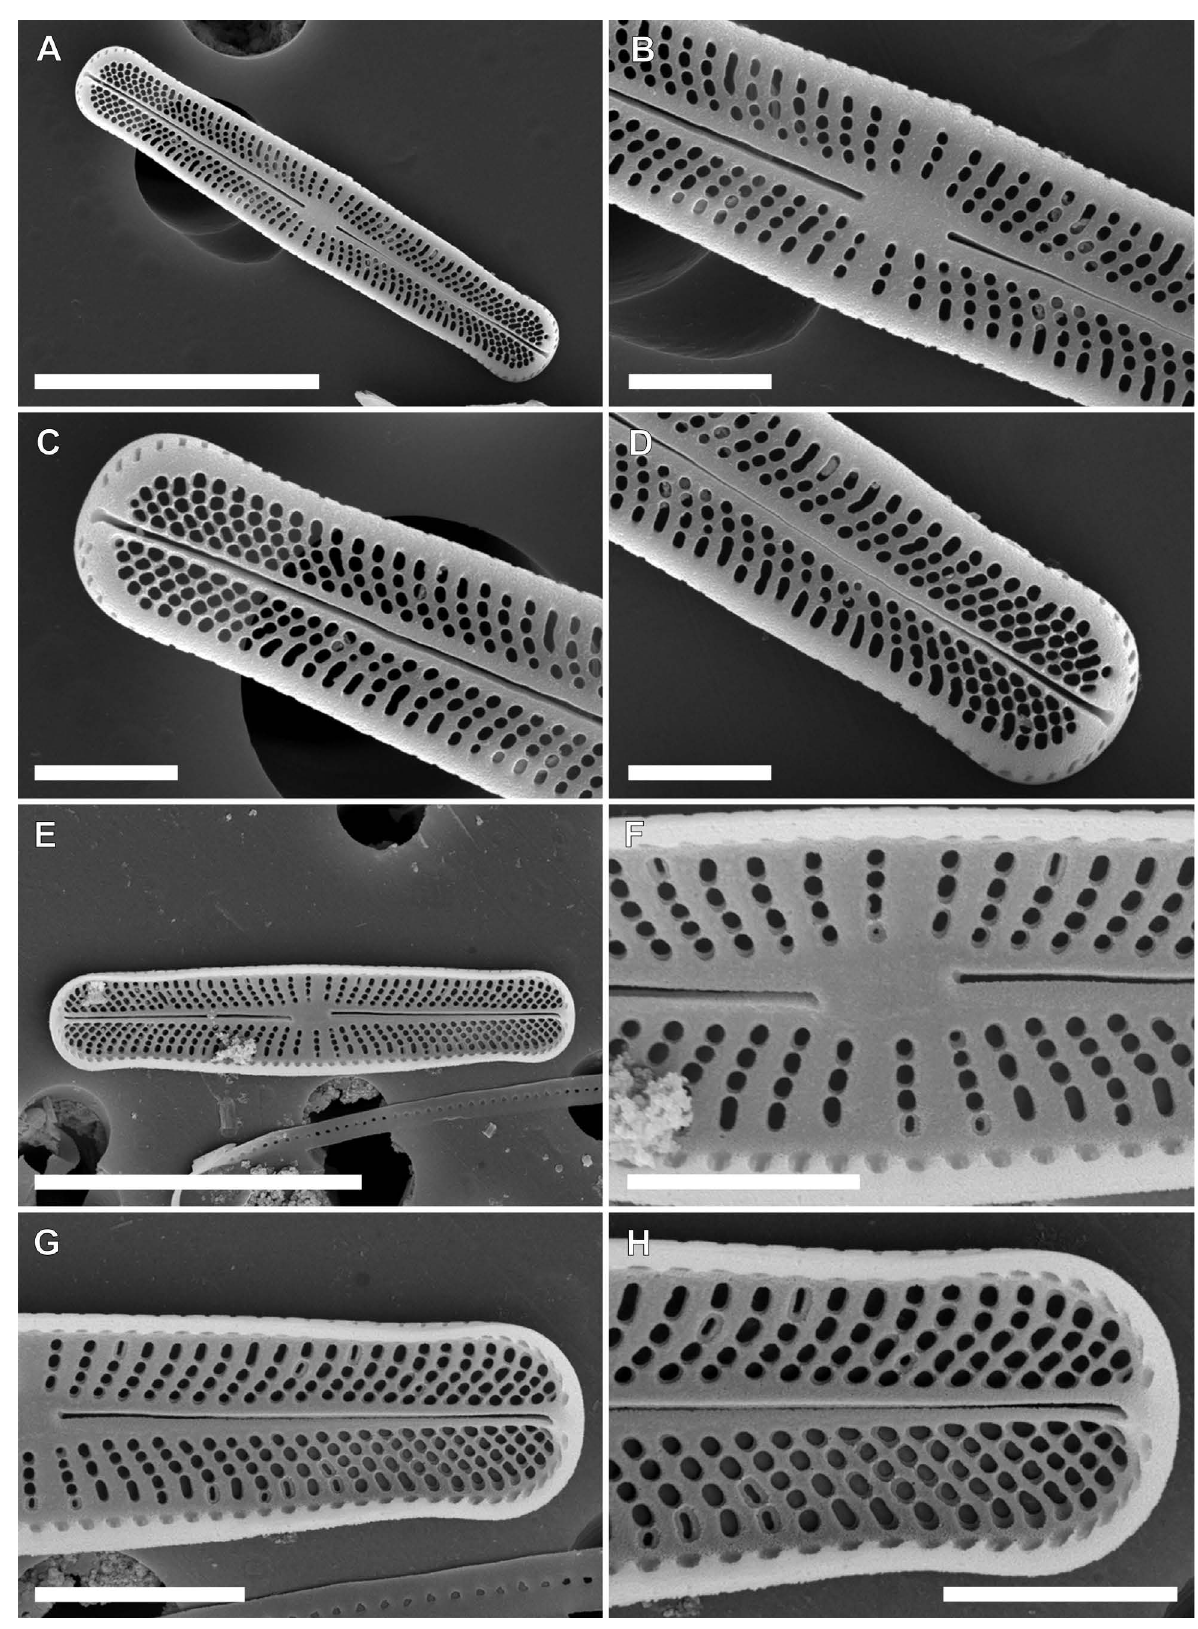
Figure 9. Achnanthidium anatolicum sp. nov., SEM micrographs. A . General external valve view of a raphe valve. B . Details of central area. C , D . Details of apices. E . General internal valve view of a raphe valve. F . Details of central area. G , H . Details of apices. Scale bars 10 µm (A, E), 2 µm (B–D,